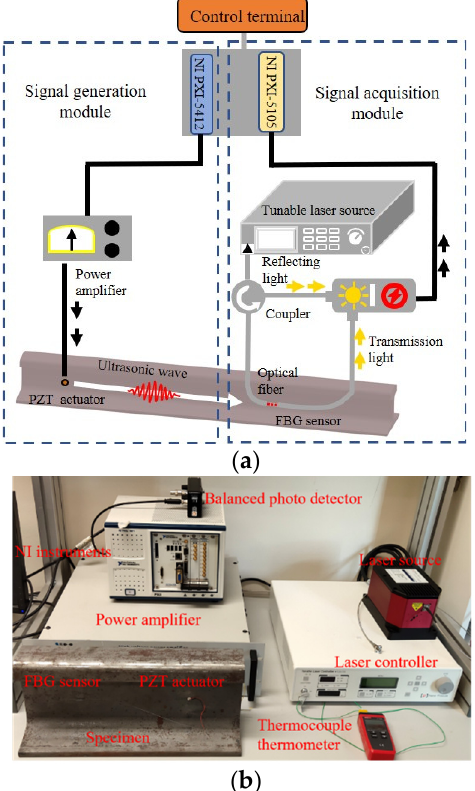
Figure 8. Experimental setup of the PZT/FBG hybrid sensing system: ( a ) schematic illustration of the experimental setup; ( b ) laboratory setup.